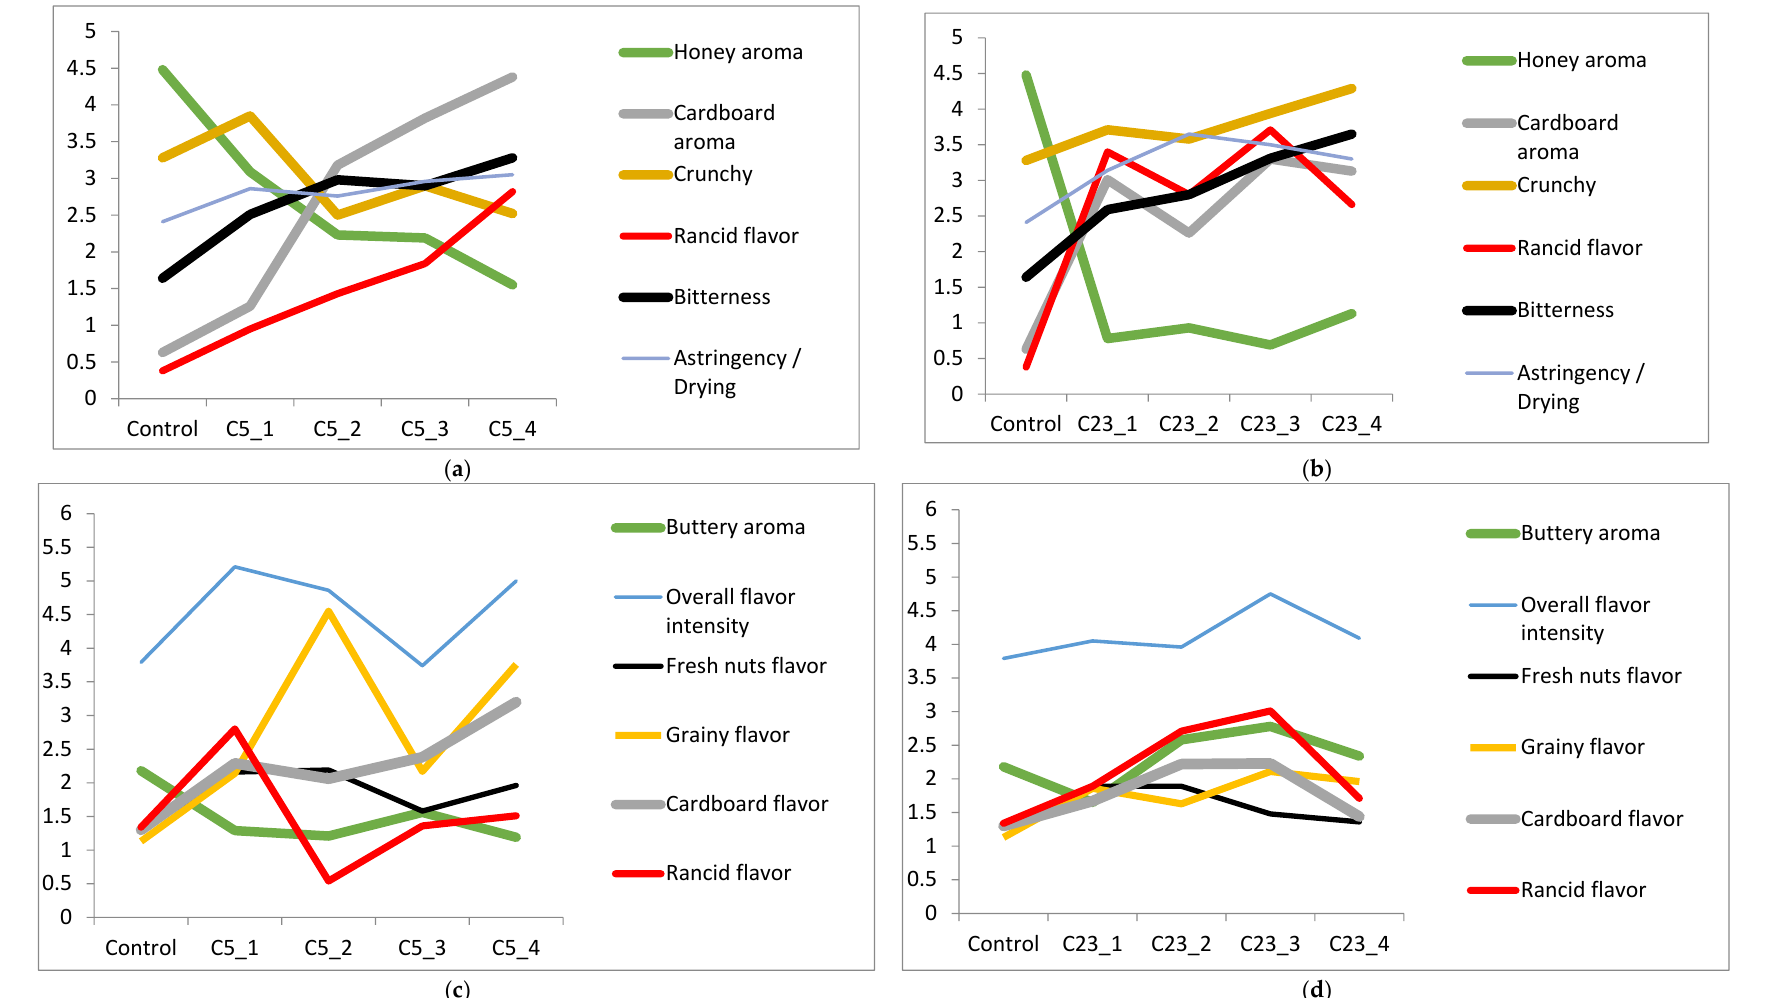
Figure 4. ( a – d ) Changes in sensory attributes of Chandler kernel (( a ) 5 °C; ( b ) 23 °C) and oil (( c ) 5 °C; ( d ) 23 °C) for 4 months.